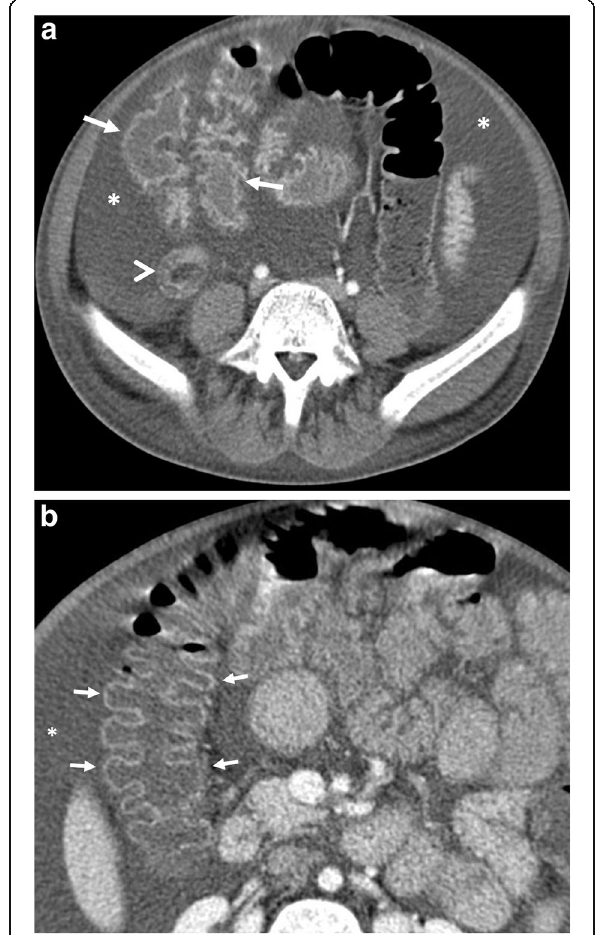
Fig. 14 A 12-year-old boy was admitted to the emergency department with a 3-day history of hematochezia and diarrhea. He also complained of abdominal pain and abdominal distention. Physical examination revealed diffuse abdominal tenderness. Increased serum levels of acute-phase reactants and leukocytosis were evident at blood analysis. a , b Axial contrast-enhanced CT images demonstrate wall thickening and contrast enhancement of the appendix vermiformis (arrowhead) and ileum (arrows, a